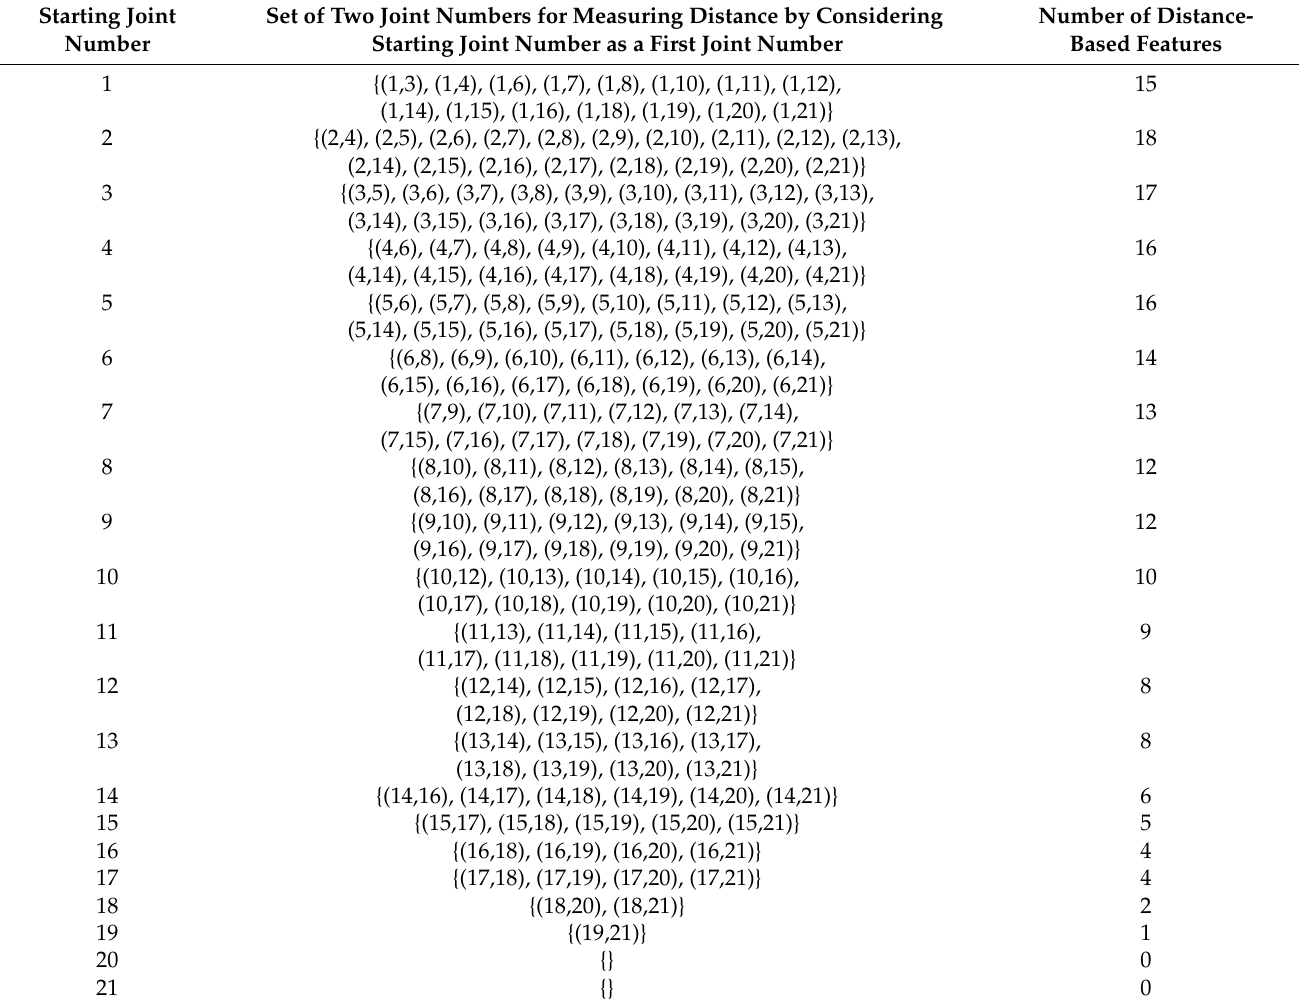
Table 2. Considered set of starting and ending joint points for calculating distance-based features. Starting Joint Set of Two Joint Numbers for Measuring Distance by